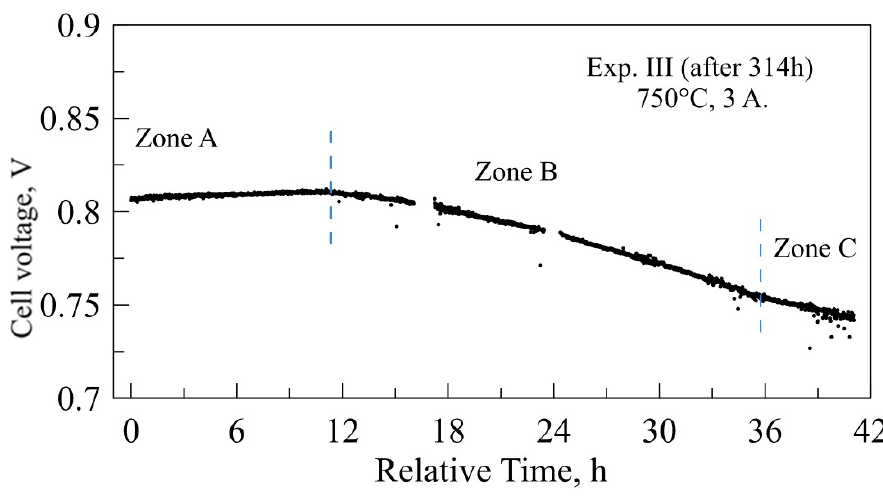
Figure 8. Voltage evolution during fly ash aerosol contamination.